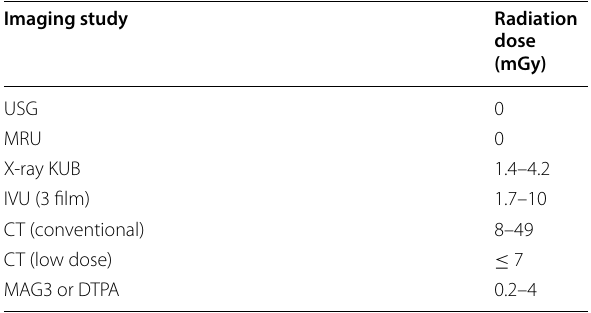
Table 2 Estimated fetal doses of radiation associated with maternal radiological